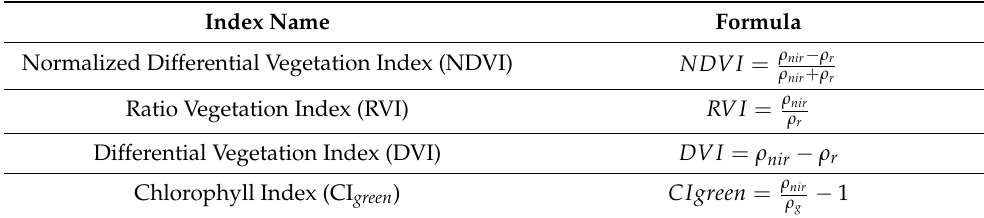
Table 3. The formulae for different vegetation